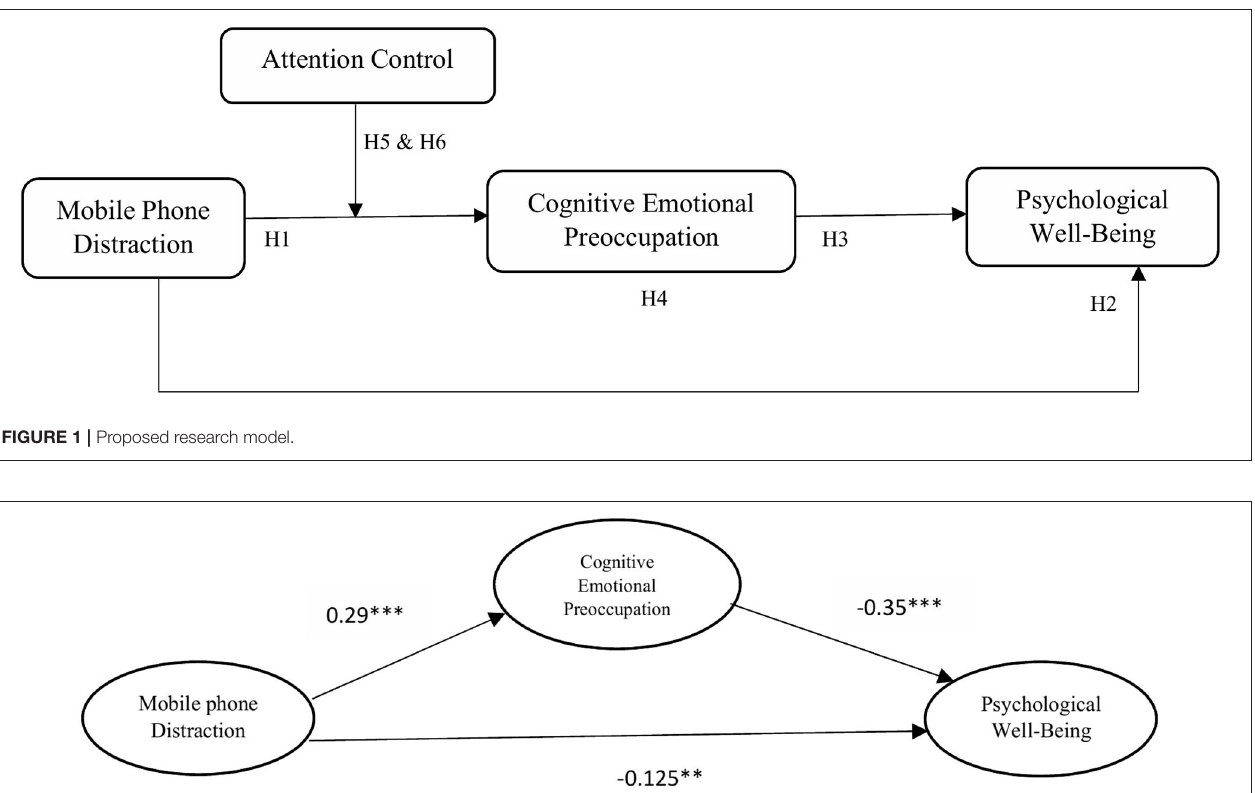
FIGURE 2 | SEM path